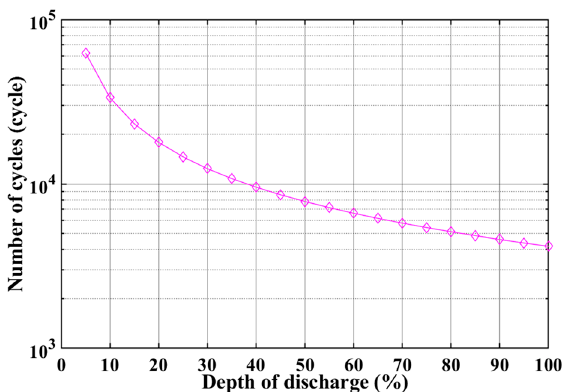
Figure 3. Example of the life cycle of a battery depending on the depth of discharge (DOD). 52 Table 3. Life cycle characteristic of a battery depending on DOD and the operation range of the state 53 of charge (SOC). 54